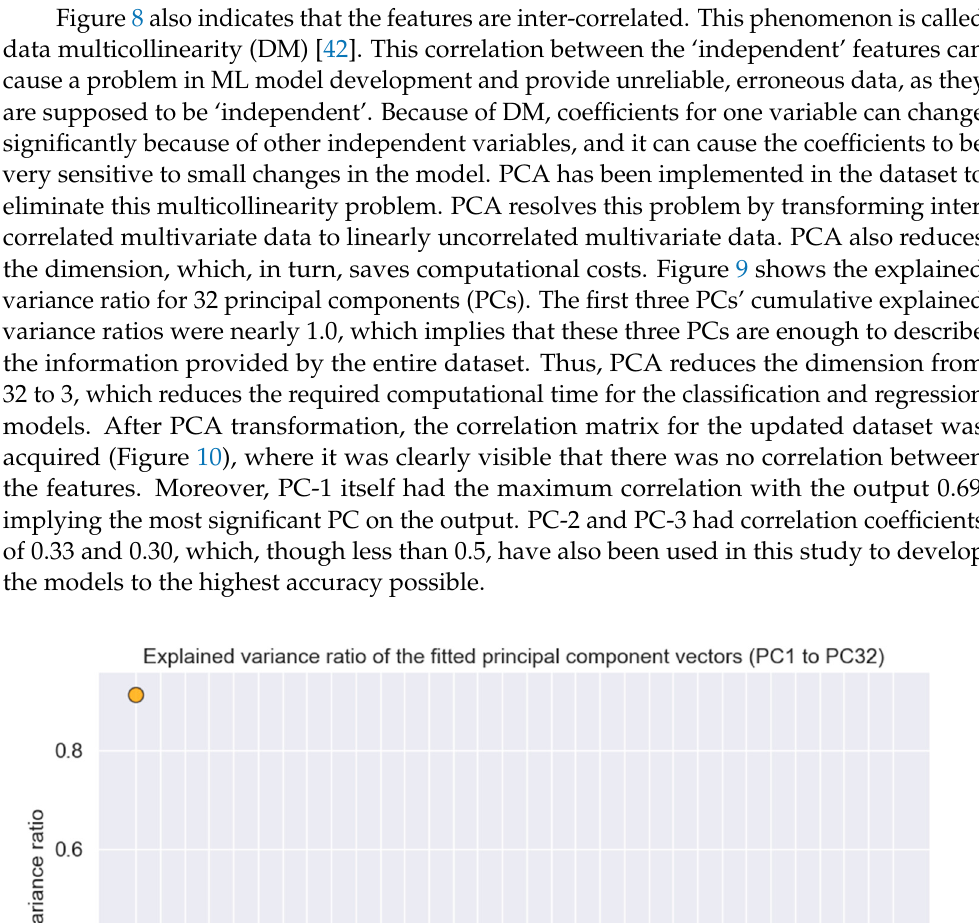
Figure 10. Correlation matrix for the parent dataset A after PCA transformation.